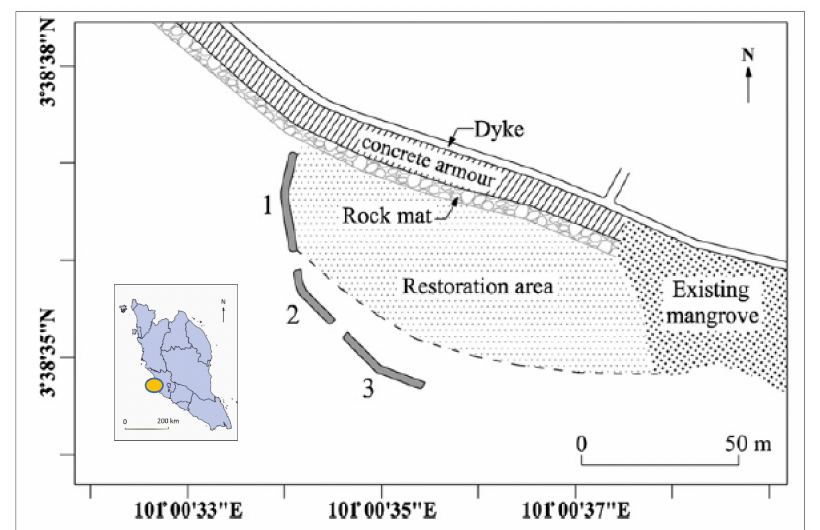
Figure 5. Emerged breakwater beach restoration in Sg Haji Dorani [78]. ‘Reprinted with permission from An integrated approach to coastal rehabilitation: Mangrove restoration in Sungai Haji Dorani, Malaysia, 2010; published by